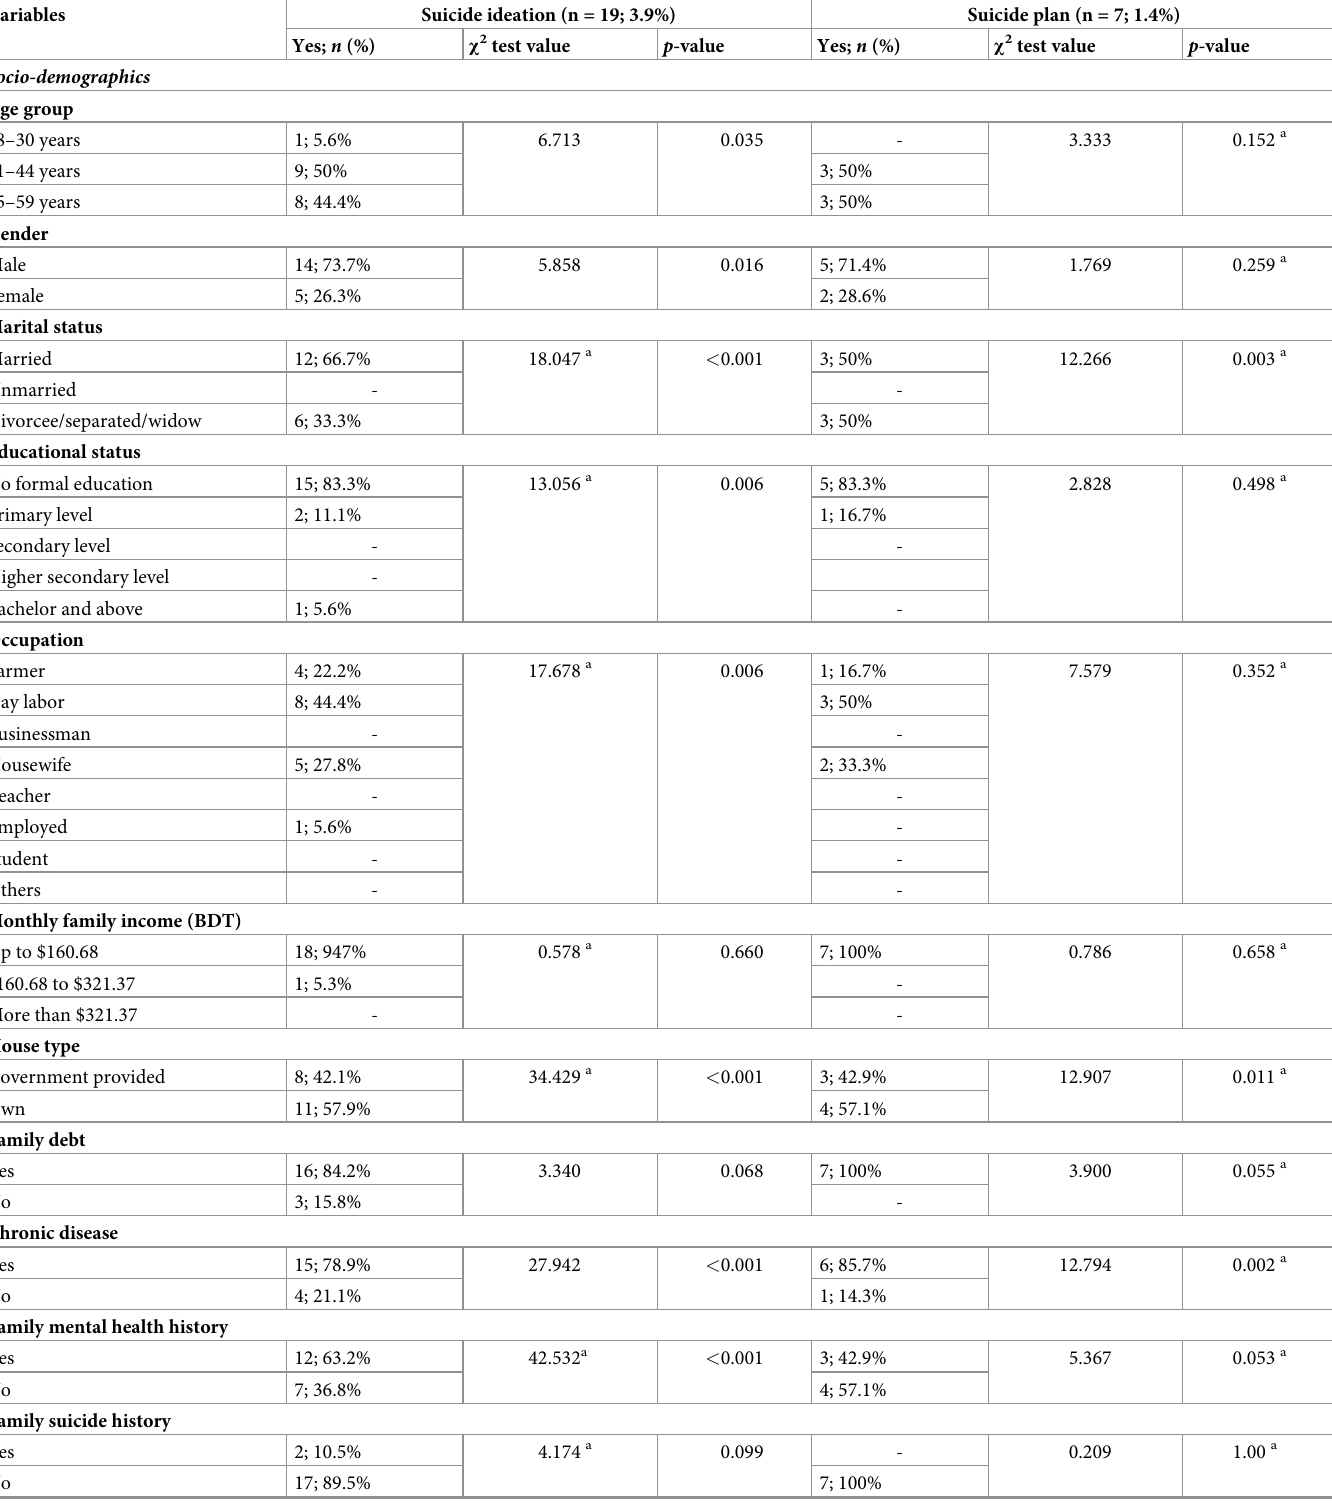
Table 3. Association between the study variables and past-year suicidal